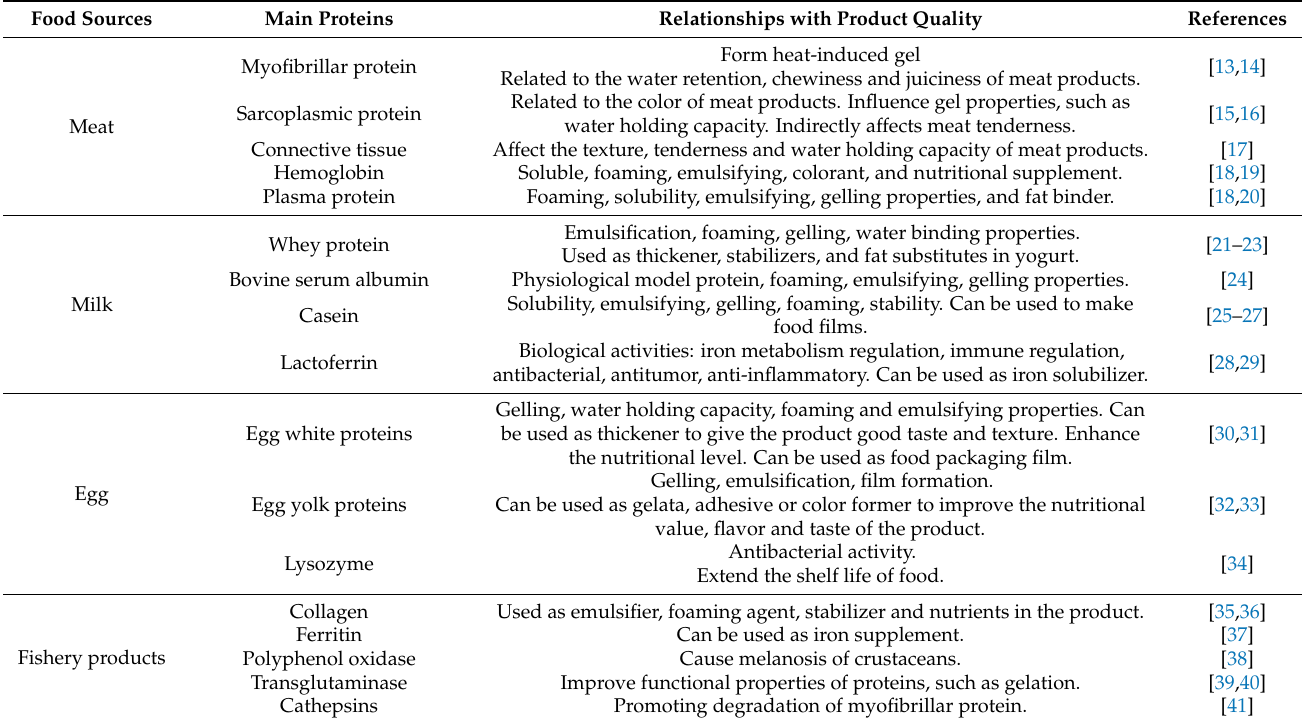
Table 1. Main proteins from animal sources and their relationship with product quality. Food Sources Main Proteins Relationships with Product